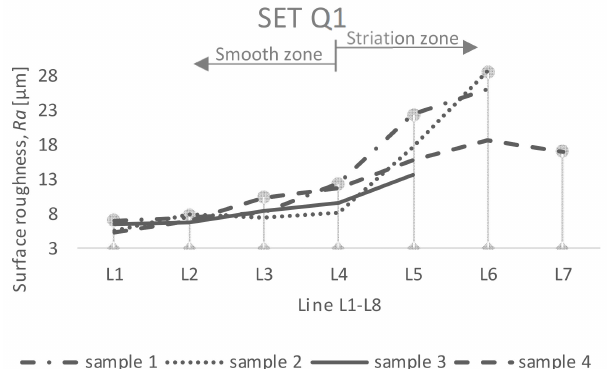
Figure 5. Evaluation of surface topography created by the AWJ (set Q1).